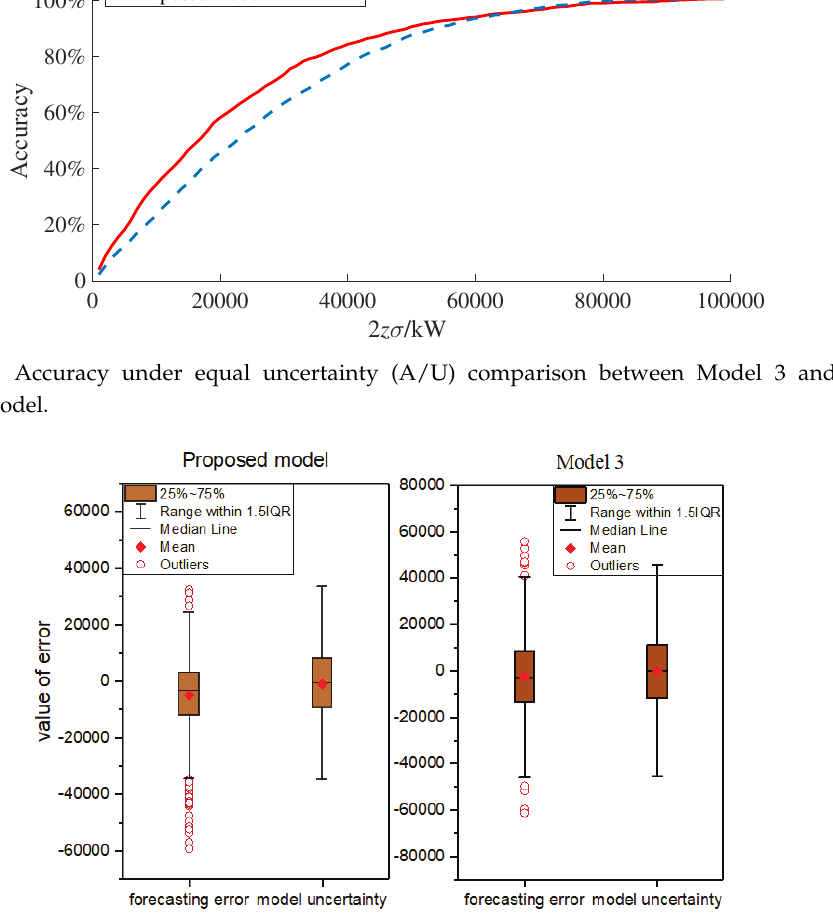
Figure 14. Statistical box-plot for forecasting error contrast to uncertainty of the proposed model and Model